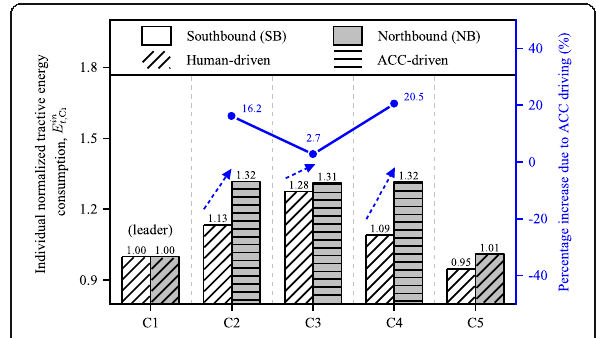
Fig. 7 ACC energy impact on the individual level